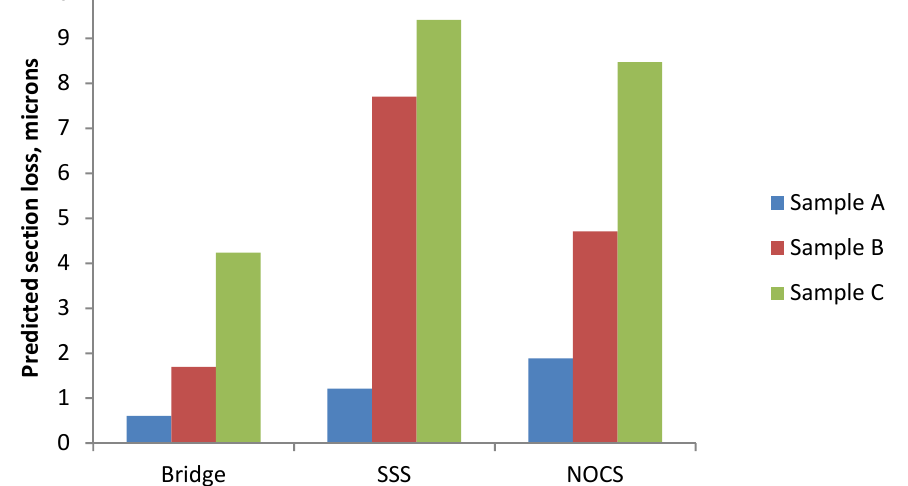
Figure 17. Predicted section loss for the three ENM methods based on R n